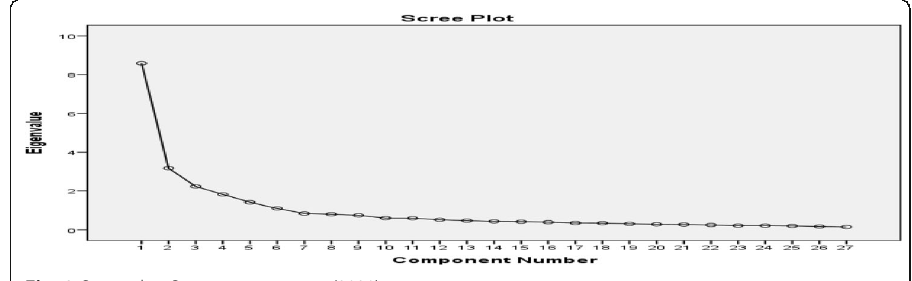
Fig. 2 Scree plot. Source: own survey